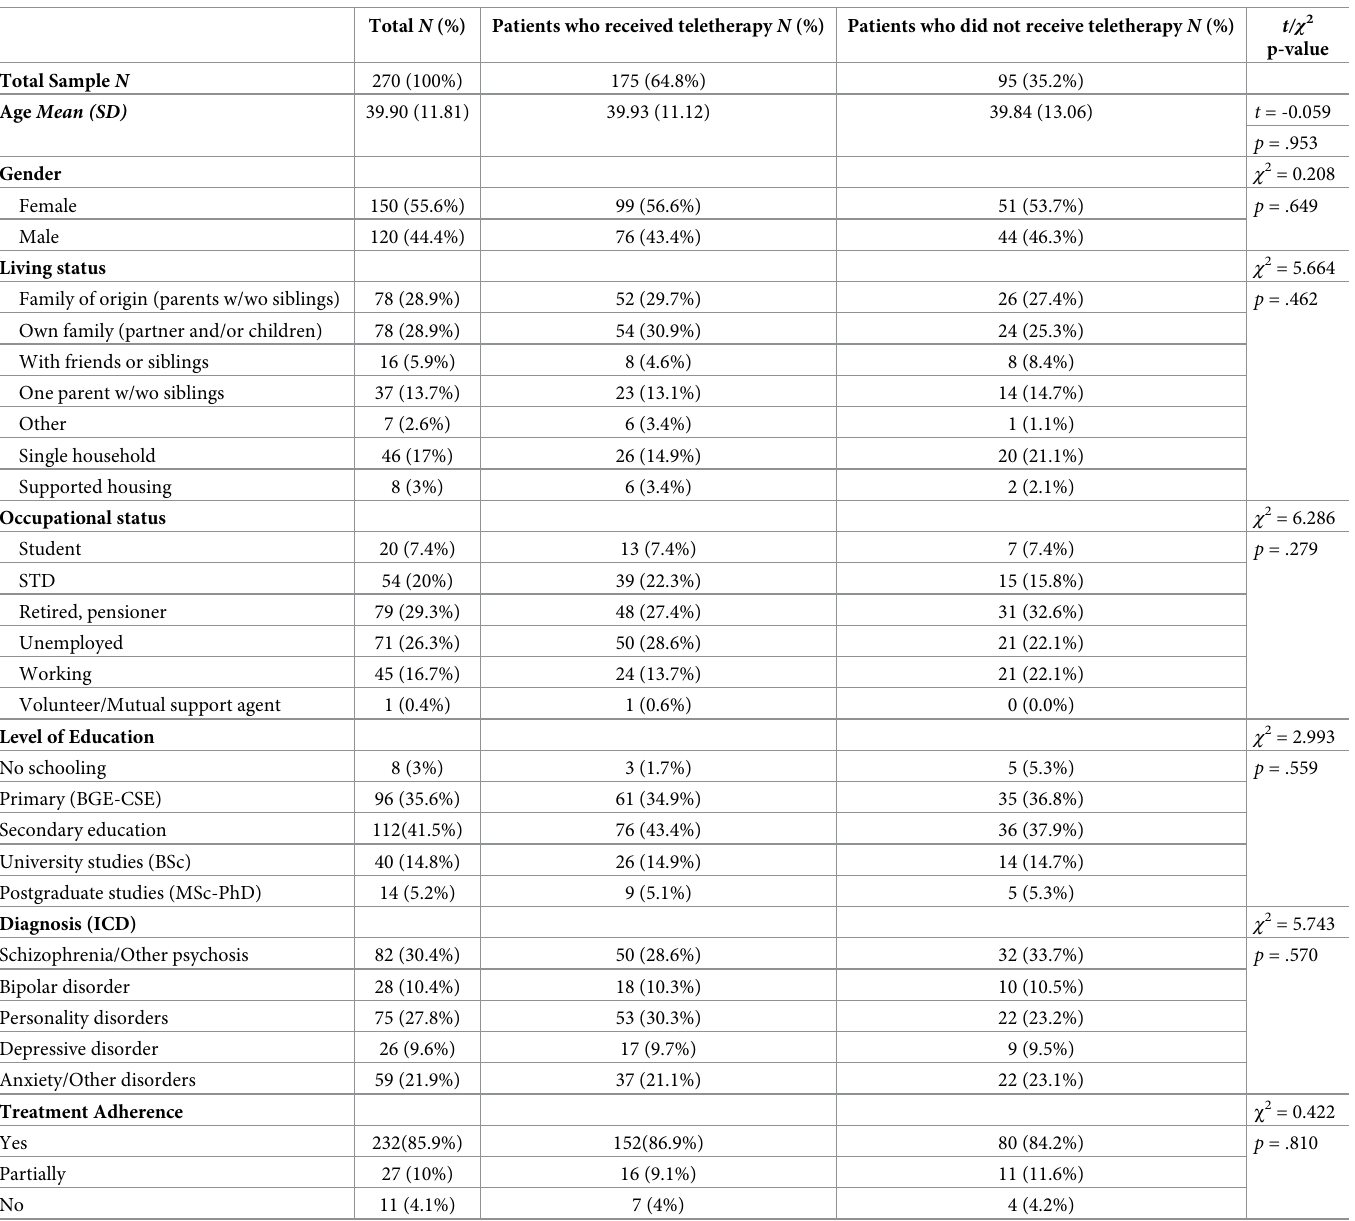
Table 1. Sociodemographic and clinical characteristics of the